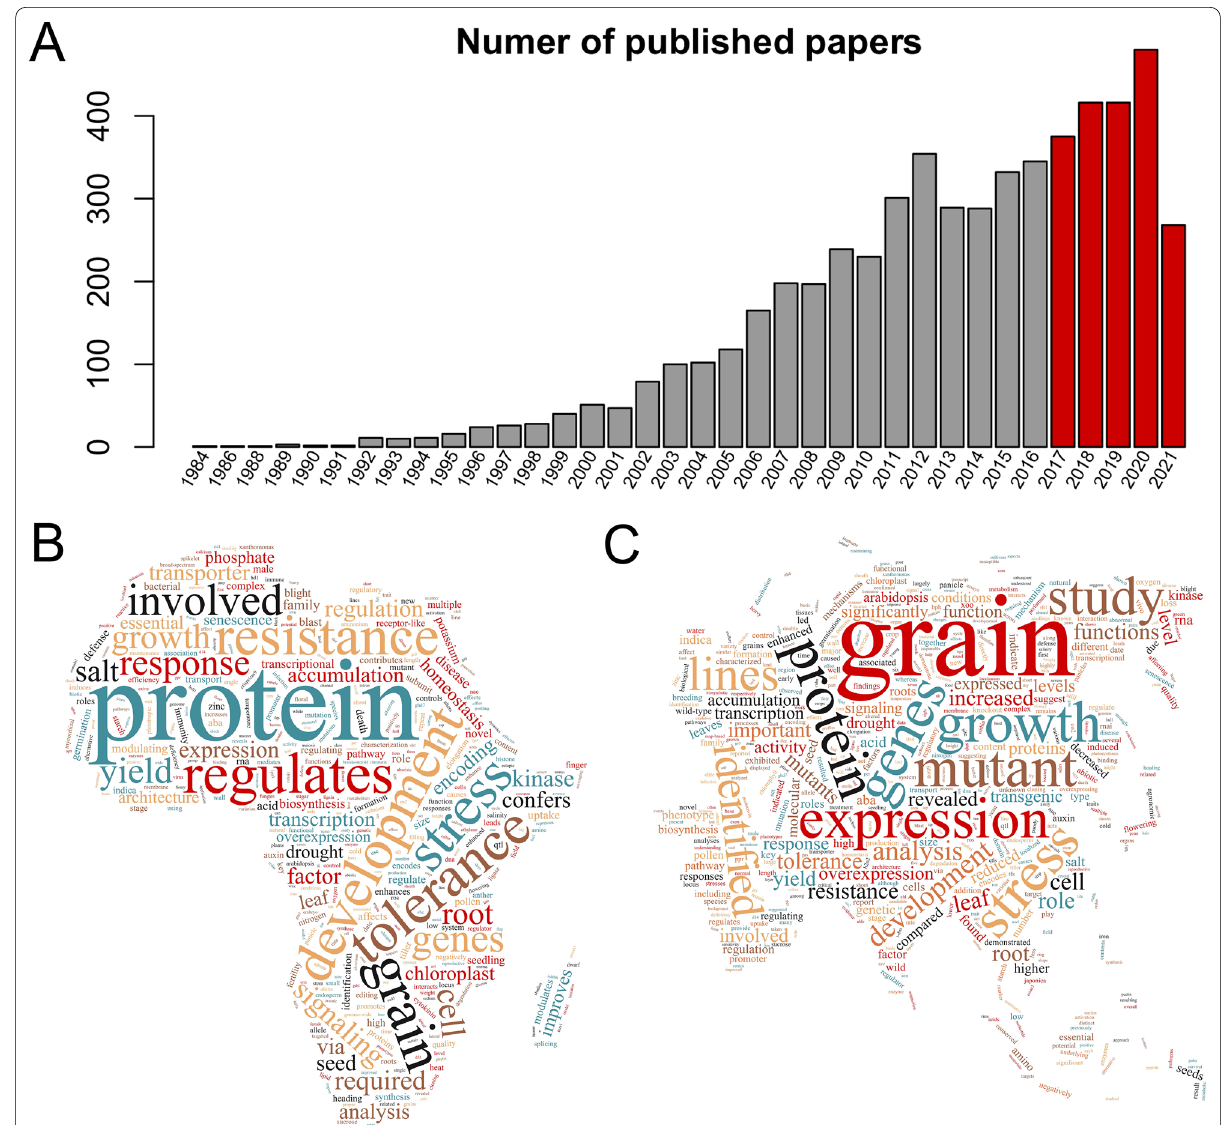
Fig. 2 Overview of the literature on functional rice genes published in the last 5 years. A The number of published papers on rice functional genomics in each year. B A word cloud of all the abstracts of published papers on rice functional genomics since 2017. C A word cloud of all the titles of published papers on rice functional genomics since